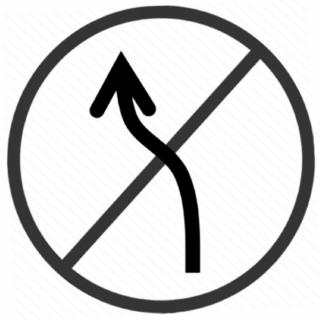
Figure 3. On-road eHMI projection symbol.